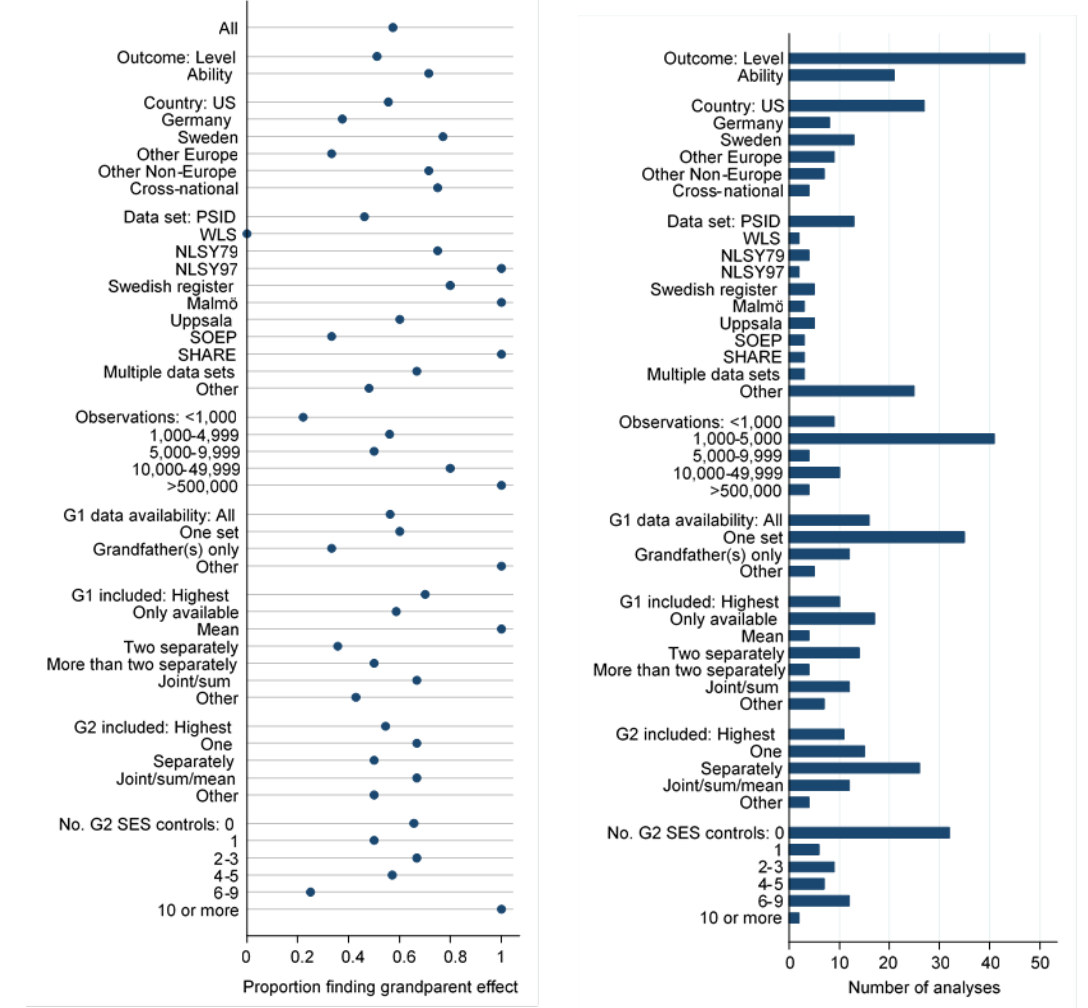
Figure 2: Proportion of analyses finding a grandparent effect (left panel) and number of analyses in each category (right panel). N = 69. Notes: There are no analyses with the number of observations between 50,000 and 500,000. PSID = Panel Study of Income Dynamics (United States); WLS = Wisconsin Longitudinal Study (United States); NLSY79 = National Longitudinal Survey of Youth 1979 (United States); NLSY97 = National Longitudinal Survey of Youth 1997 (United States); Malmö = Generations Emanating from the Malmö Study (Sweden); Uppsala = Uppsala Birth Cohort Study Multigenerational Database (Sweden); SOEP = German Socio-Economic Panel (Germany); SHARE = The Survey of Health, Ageing and Retirement in Europe (27 European countries and